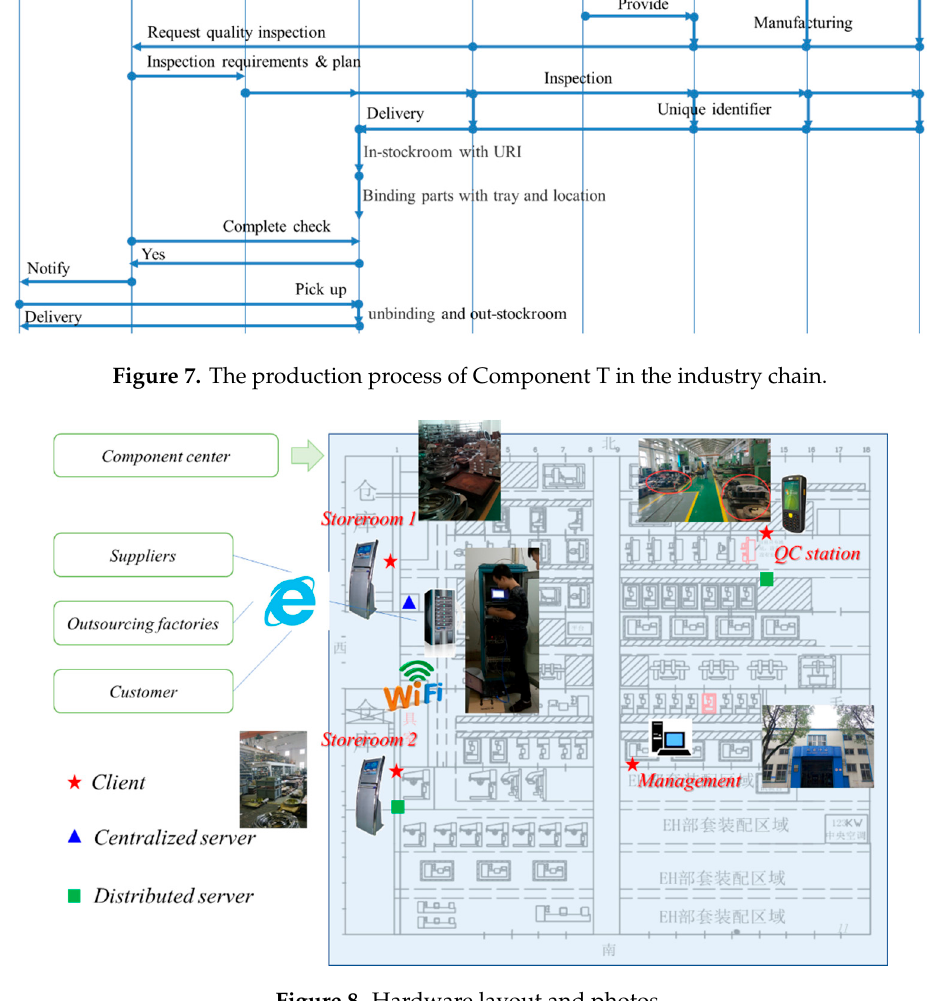
Figure 8. Hardware layout and photos.